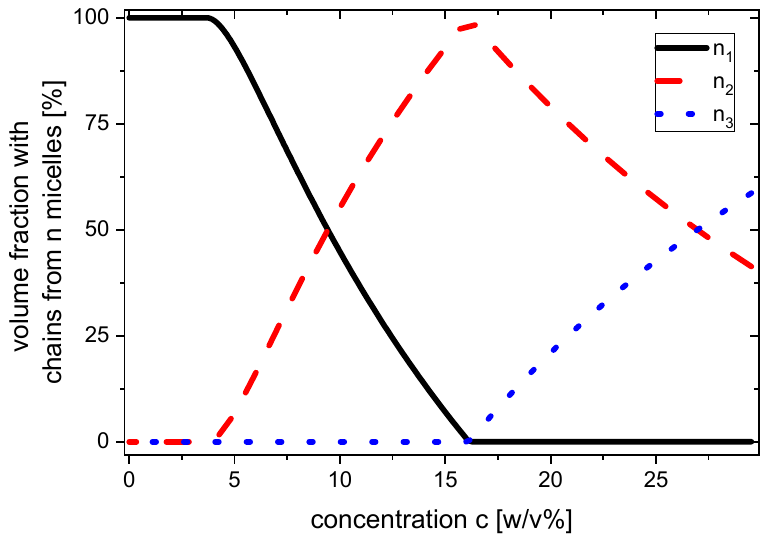
Figure 3. Volume fraction of non ( n 1 ), binary ( n 2 ), and triple ( n 3 ) coronae overlap as a function of concentration.